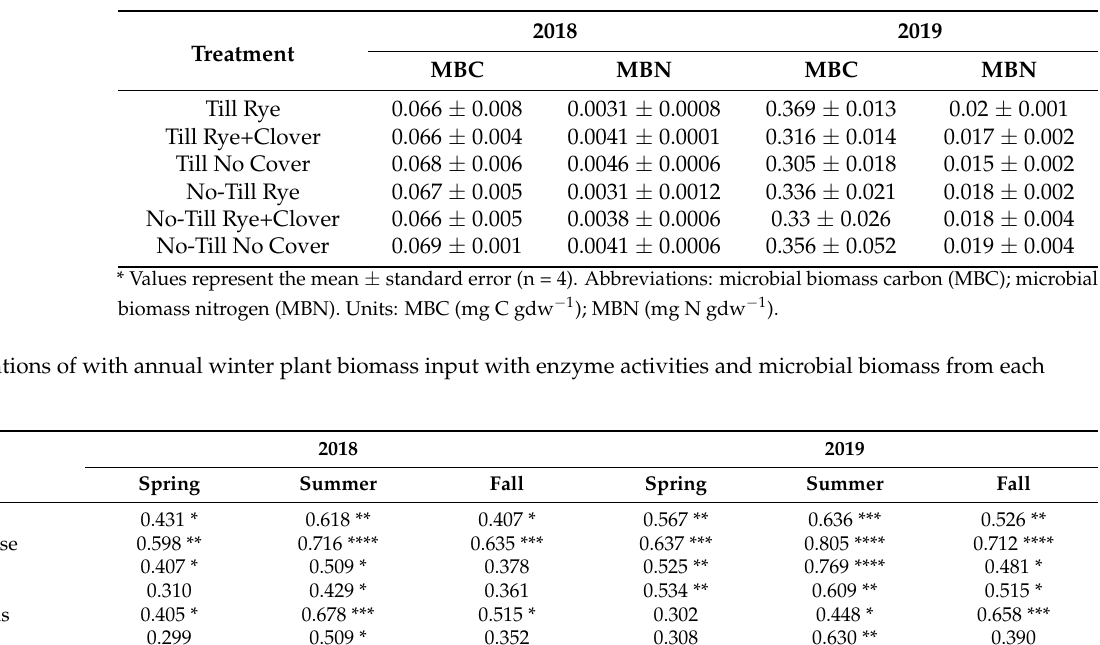
Figure 4. Microbial biomass carbon ( A ) and microbial biomass nitrogen ( B ) in 0–5 cm soil from till (T) and no-till (NT) plots planted with winter cover crop treatments of rye only (R), rye+clover (RC), and no cover (NC) during the 2018 and 2019 soybean growing season. Values represent the mean ± standard error (n = 4). Statistical significance between treatments for each timepoint are denoted by different letters ( α = 0.05). Table 2. Microbial biomass C and N in 5–15 cm soil in spring 2018 and 2019 *.